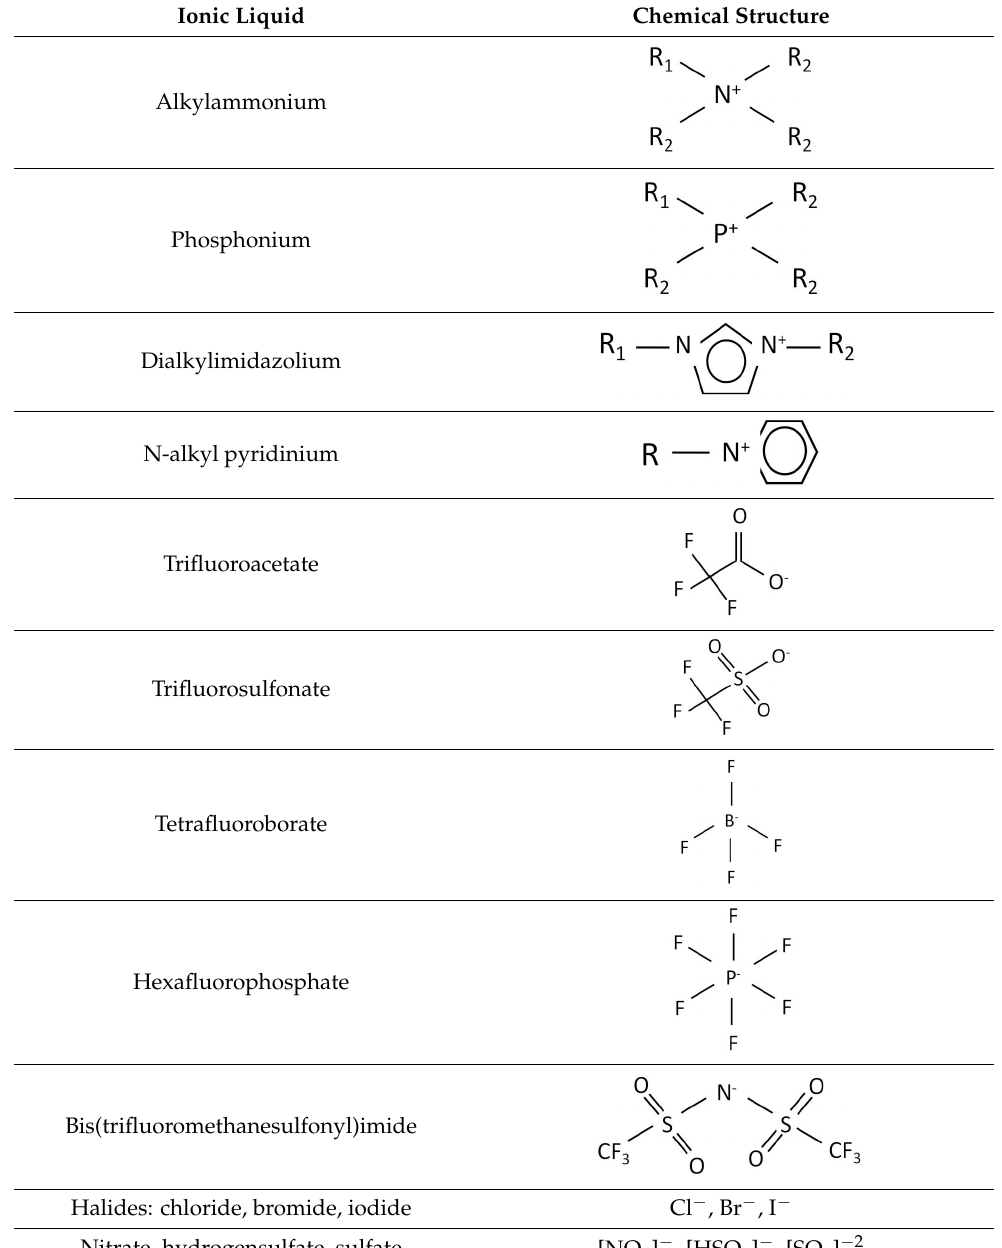
Table 4. A few examples of structures of ionic liquids (R, R1, and R2 = alkyl groups)